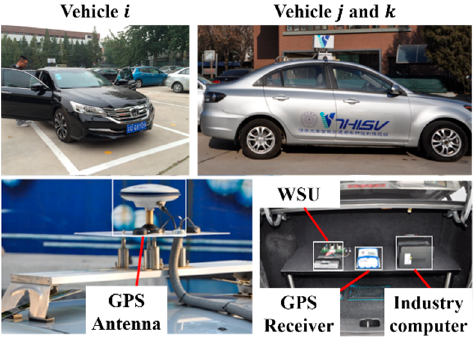
Figure 5. Experimental vehicles. WSU, GPS Receiver, and industry computer are installed in the trunk of each test vehicle.